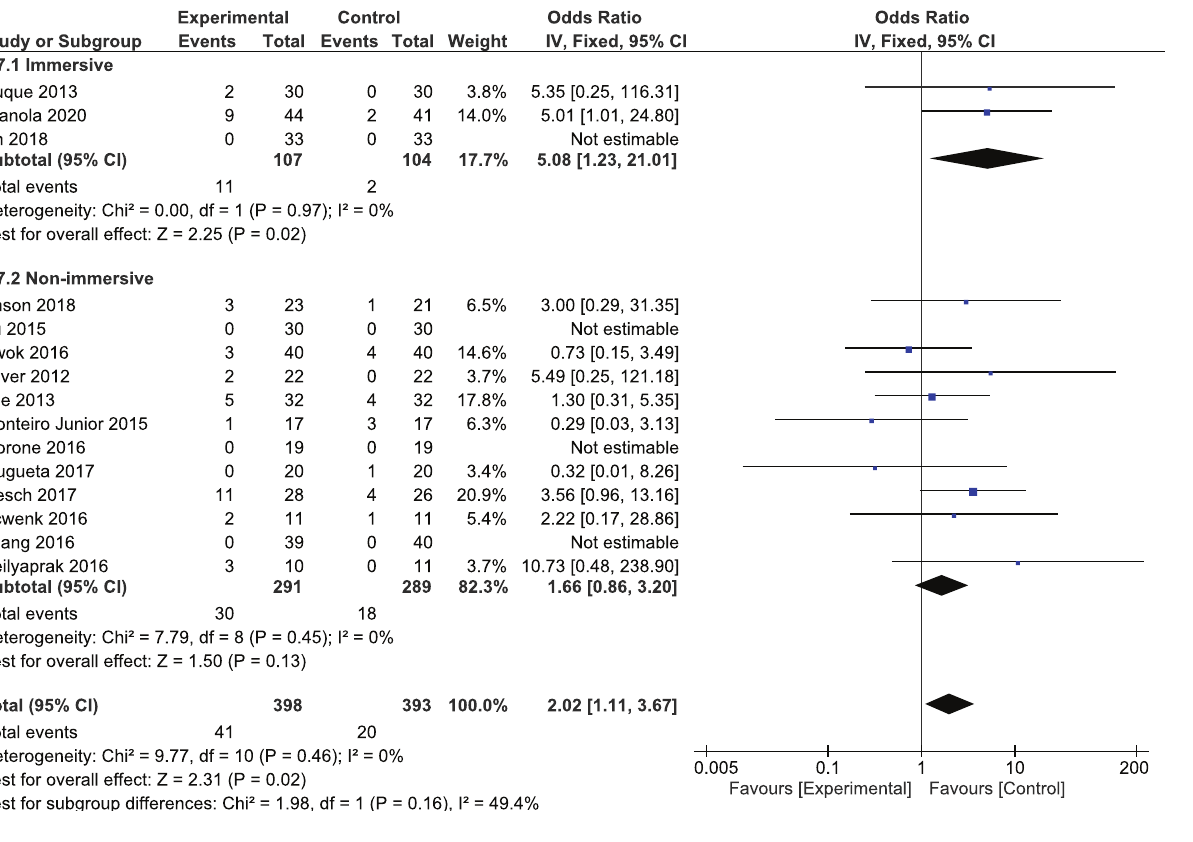
FIGURE 6 | Forest plot of study